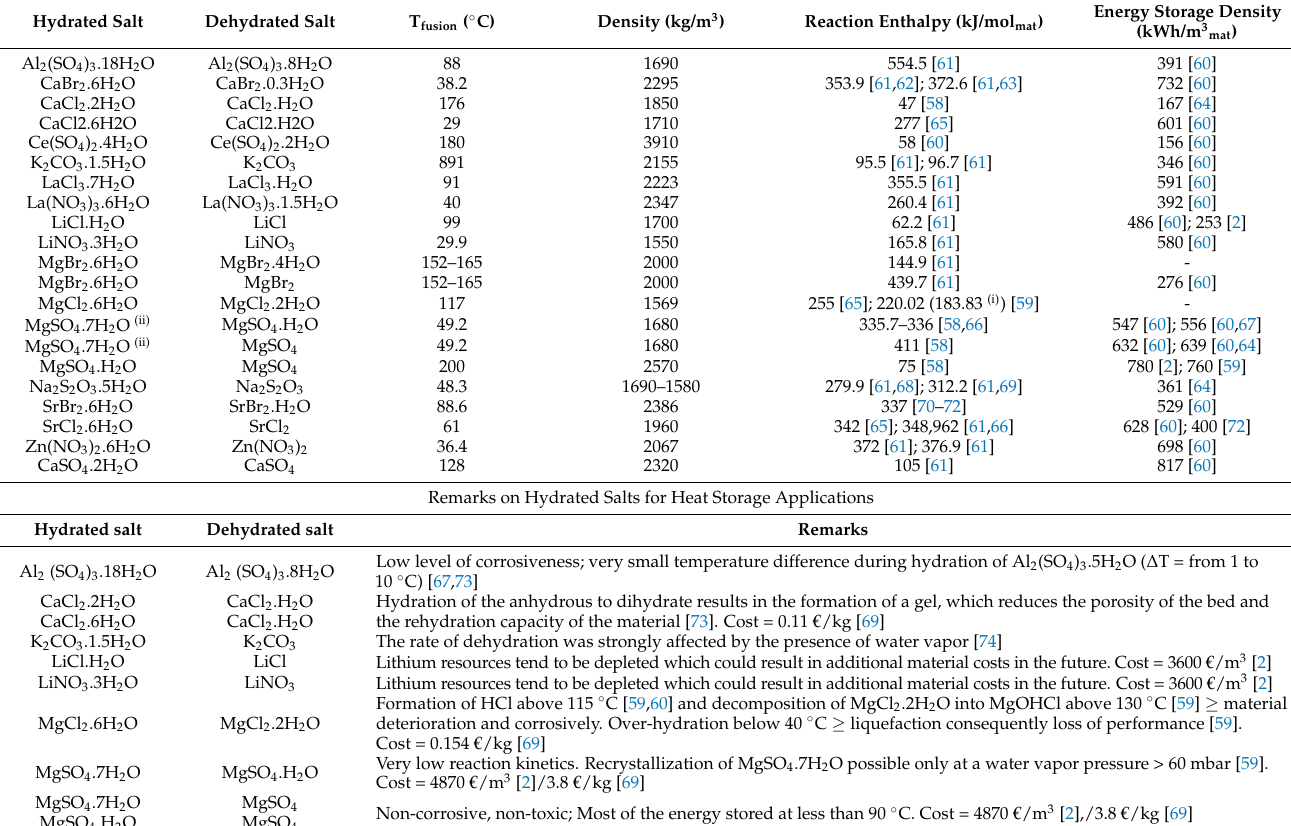
Table 3. Hydrated salts and their